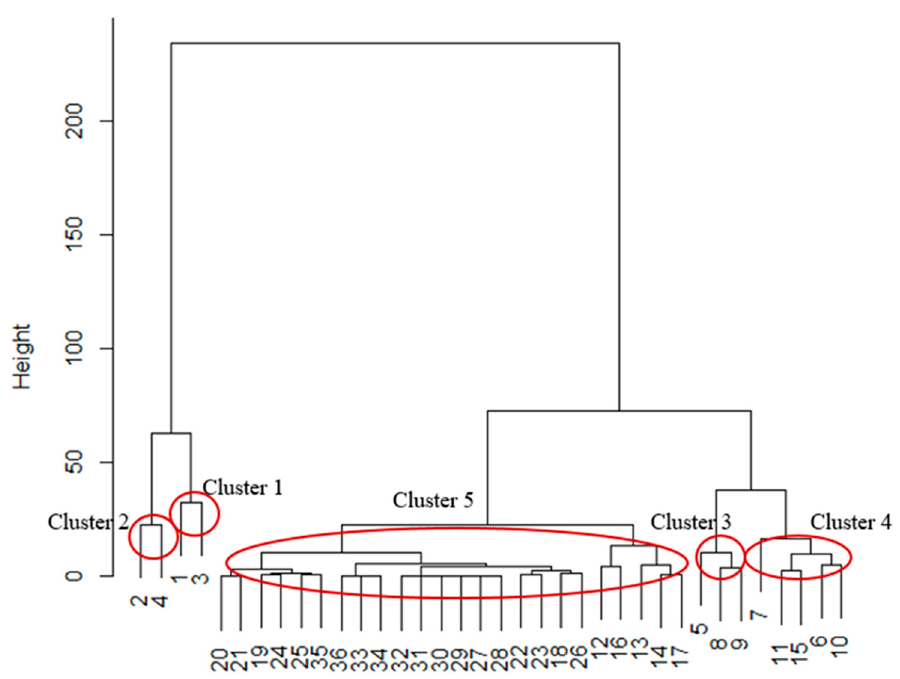
Figure 5. Dendrogram of identified clusters of fungal genera based on several isolation cases from different parts of C. japonica. The numbers in dendrogram denote the genera of fungi: 1— Fusarium